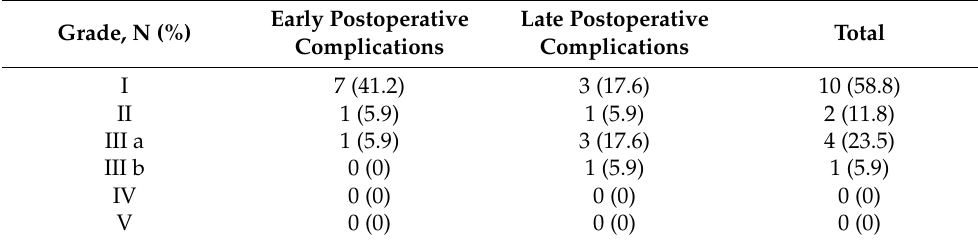
Table 3. Clavien–Dindo classification of surgical